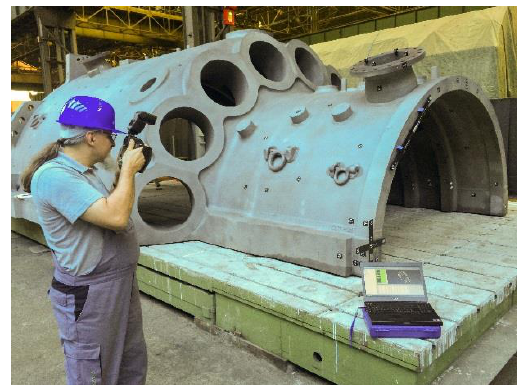
Figure 23: Image capturing with high-resolution digital camera (Image: Siemens)